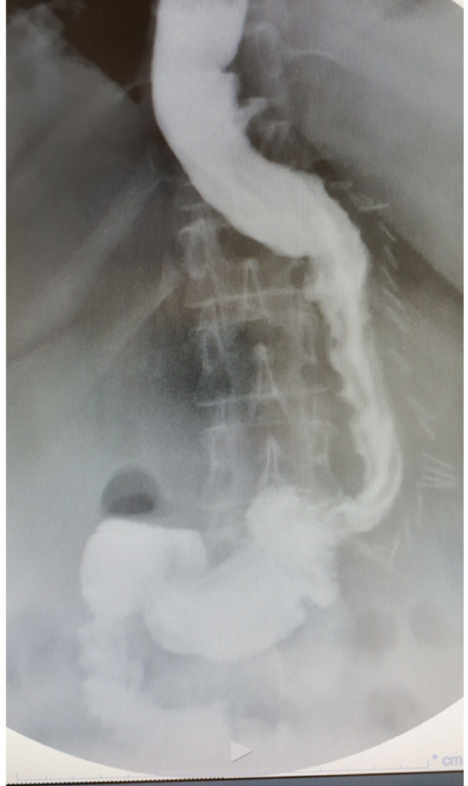
Figure 6. Postoperative upper gastrointestinal